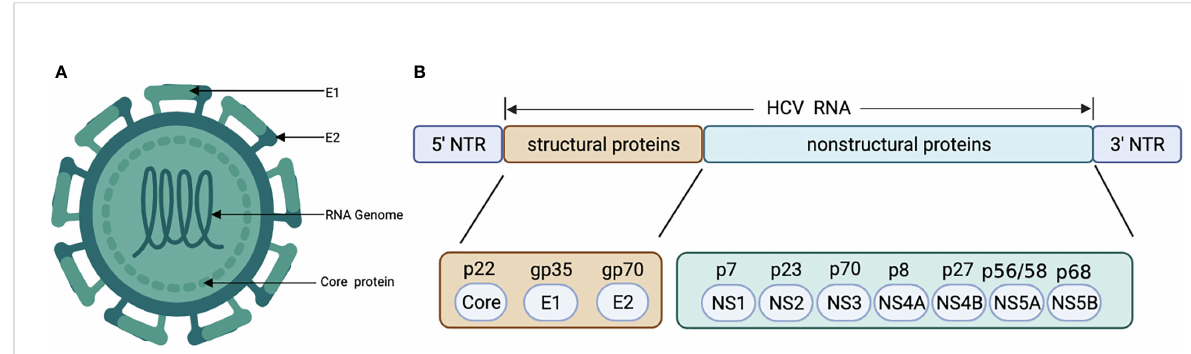
FIGURE 2 Structural (A) and genetic organization (B) of HCV. HCV, Hepatitis C